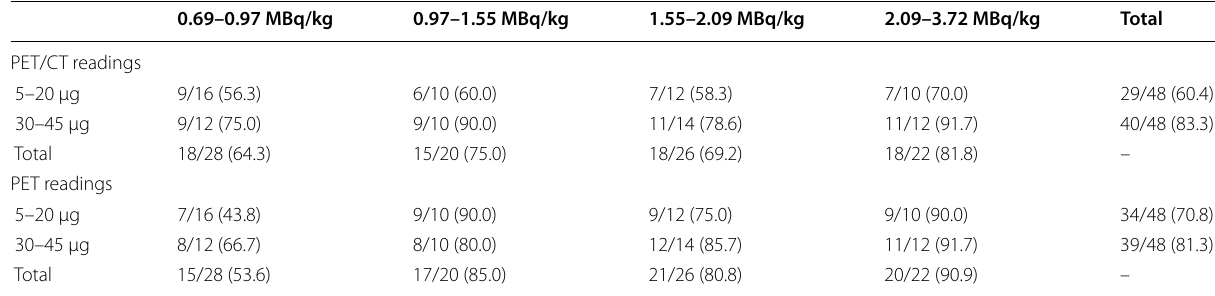
During the image quality readings, each image was assigned a “1” (for optimal image quality) or a “0” (for non-optimal image quality). The numerator of the image quality score is the sum of both readers’ scores, and the denominator is the total number of PET/CT and PET scans that were read and scored Data are presented as n / N (%) CT computed tomography, PET positron emission